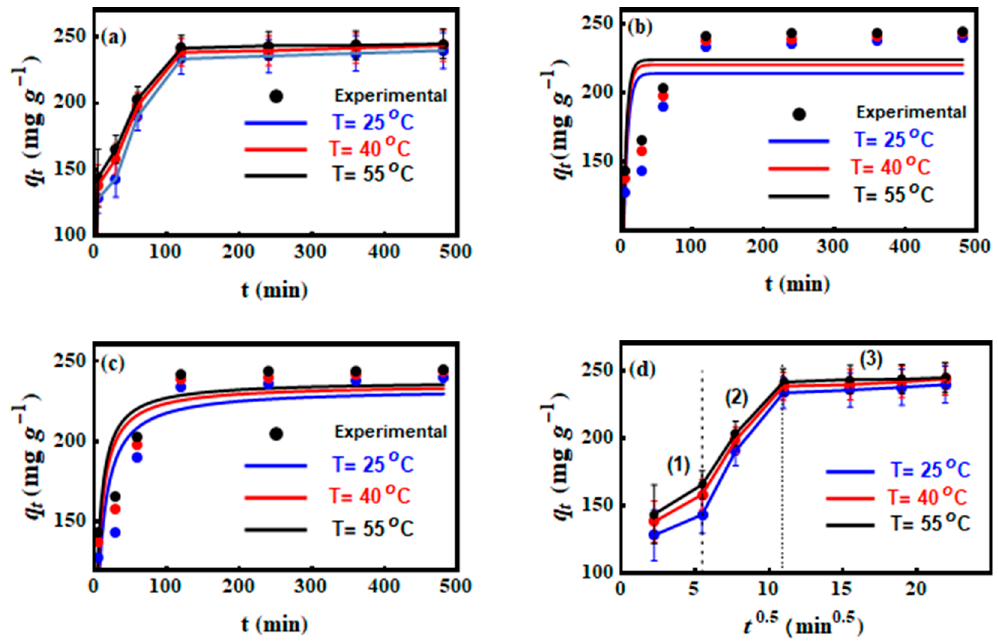
Figure 5. Kinetic studies of CV adsorption on MNP/CTAB–EC composite. ( a ) Effect of contact time, ( b ) Pseudo-first order model, ( c ) Pseudo-second order model and ( d ) intra-particle diffusion model at different temperatures (25, 40, and 55 °C). Table 3. Parameters of kinetic models for the adsorption of CV on MNP / CTAB-EC